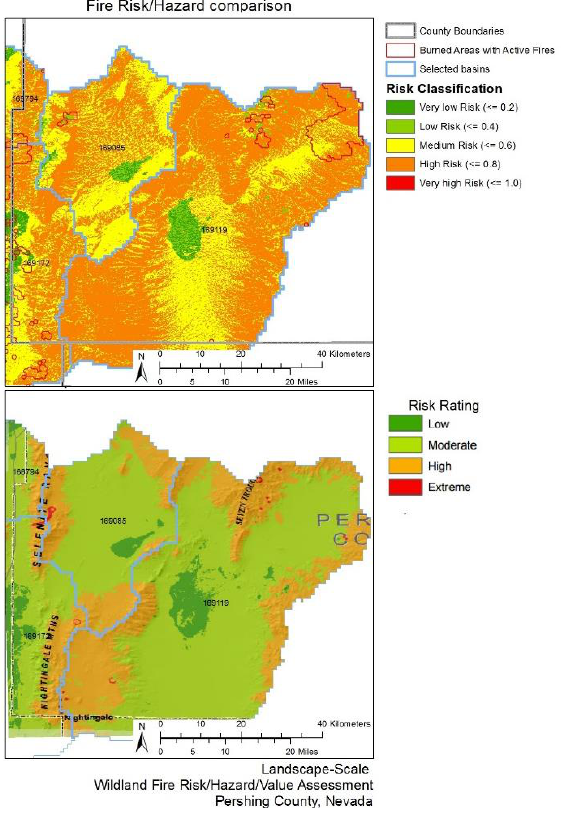
Figure 3: Fire Risk/Hazard comparison. Top: Wildfire Risk Classification for selected catchments in Pershing County, Nevada as a subset from the North America Study